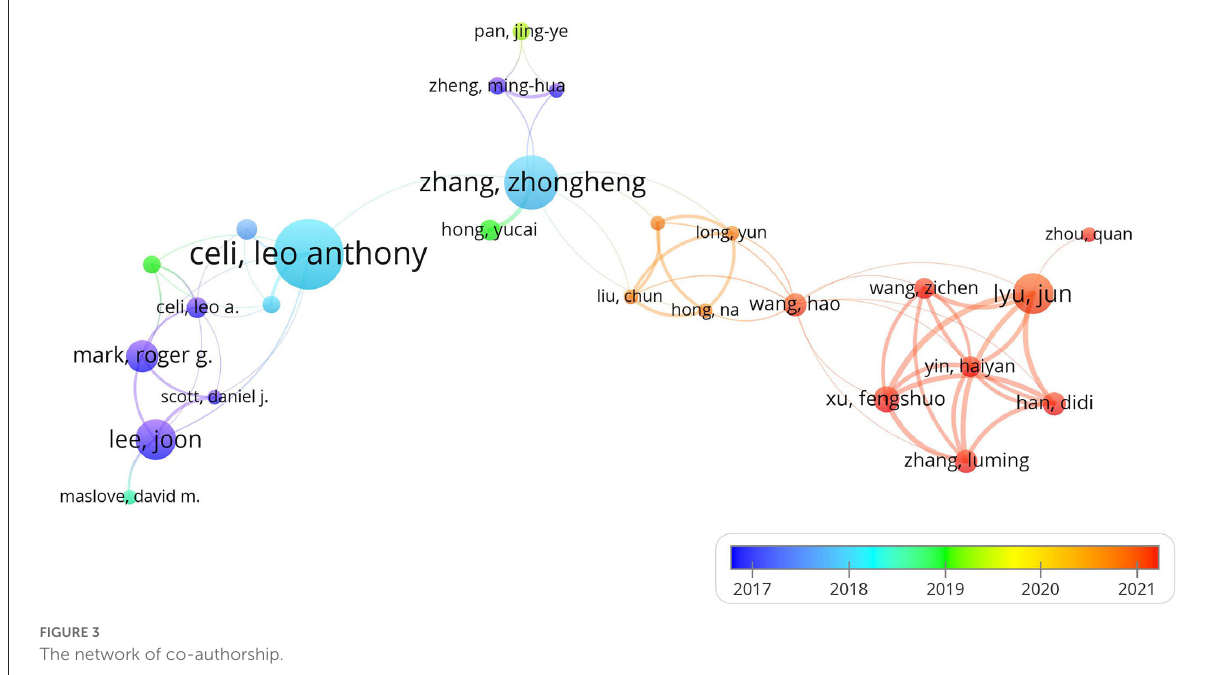
FIGURE3 The network of